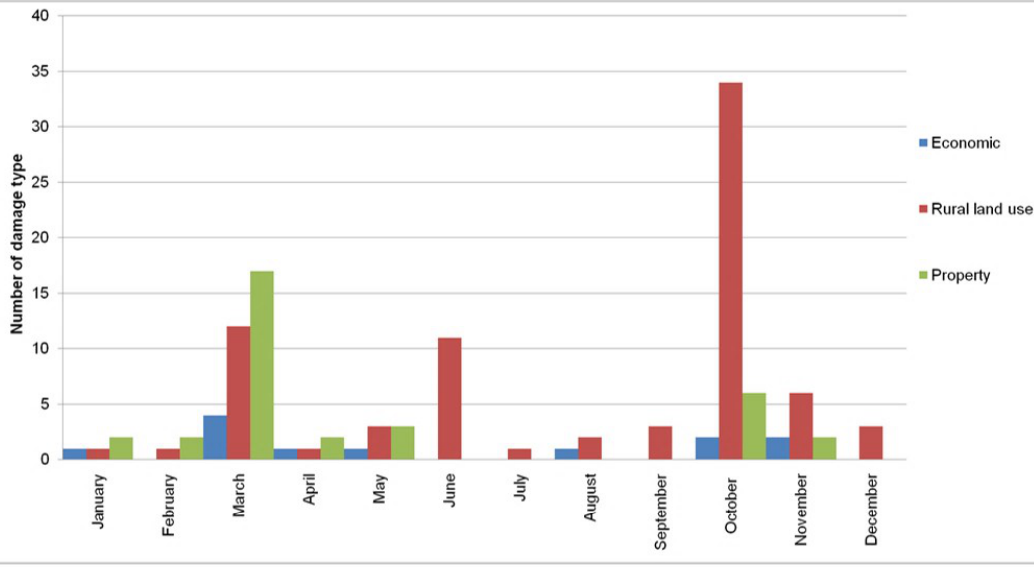
Figure 9. The monthly distribution of the type of